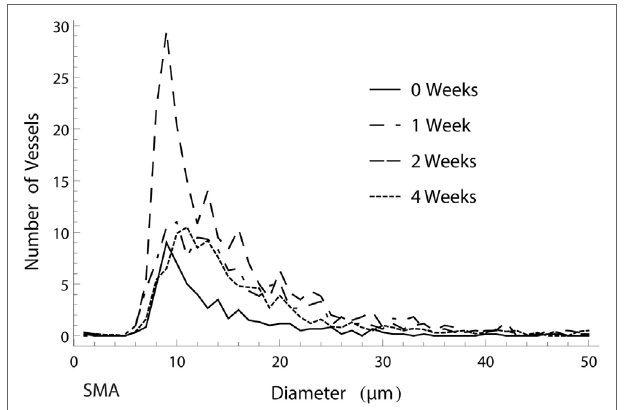
FIGURe 6 | Histogram of the amount of smooth muscle actin (SMA) positive vessels of different diameters over the course of 4 weeks. The numerically largest gain in vessels was observed in week 2 in the capillary